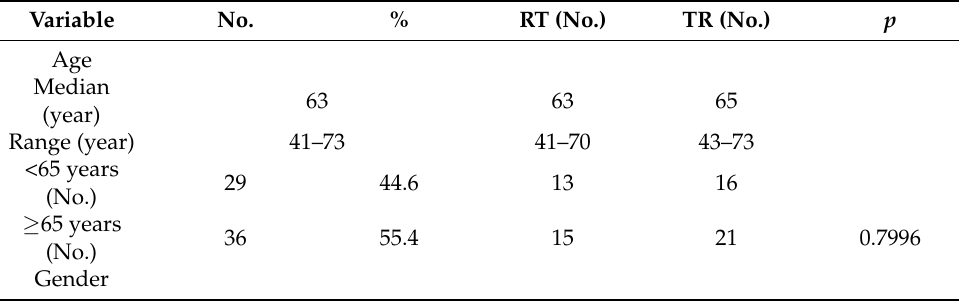
Table 1. Clinico-pathological characteristics of